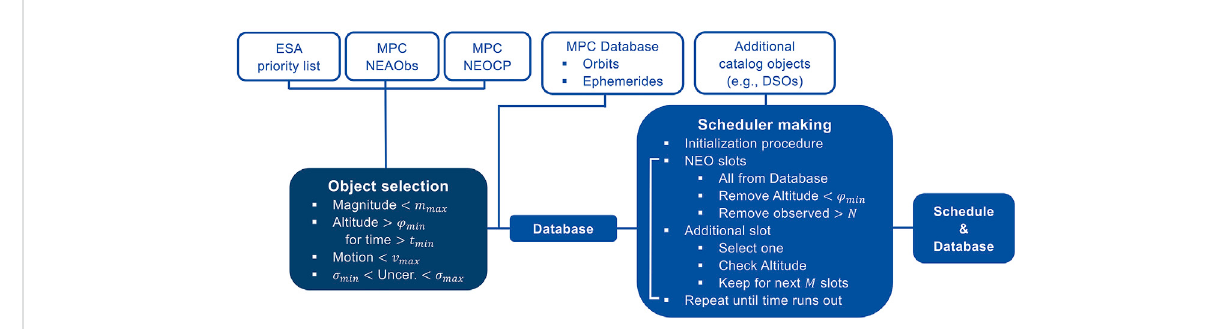
FIGURE 4 Pre-Observation Pipeline illustrated with its work fl ow. First suitable NEOs are selected from ESA ’ s NEOCC Priority List, the MPC NEA Observation Planning Aid (NEAObs) and the MPC NEO Con fi rmation Page (NEOCP) with given boundaries on the magnitude, altitude, motion and skyuncertainty.Orbits andEphemerides aredownloaded fromtheMPCDatabaseand convertedfor KStars.With theselected objectsandadditional catalogobjectsanobservationscheduleisautomaticallymadeinanoptimalrunningorder.ThesystemcontinueswiththeObservationpipeline in Figure